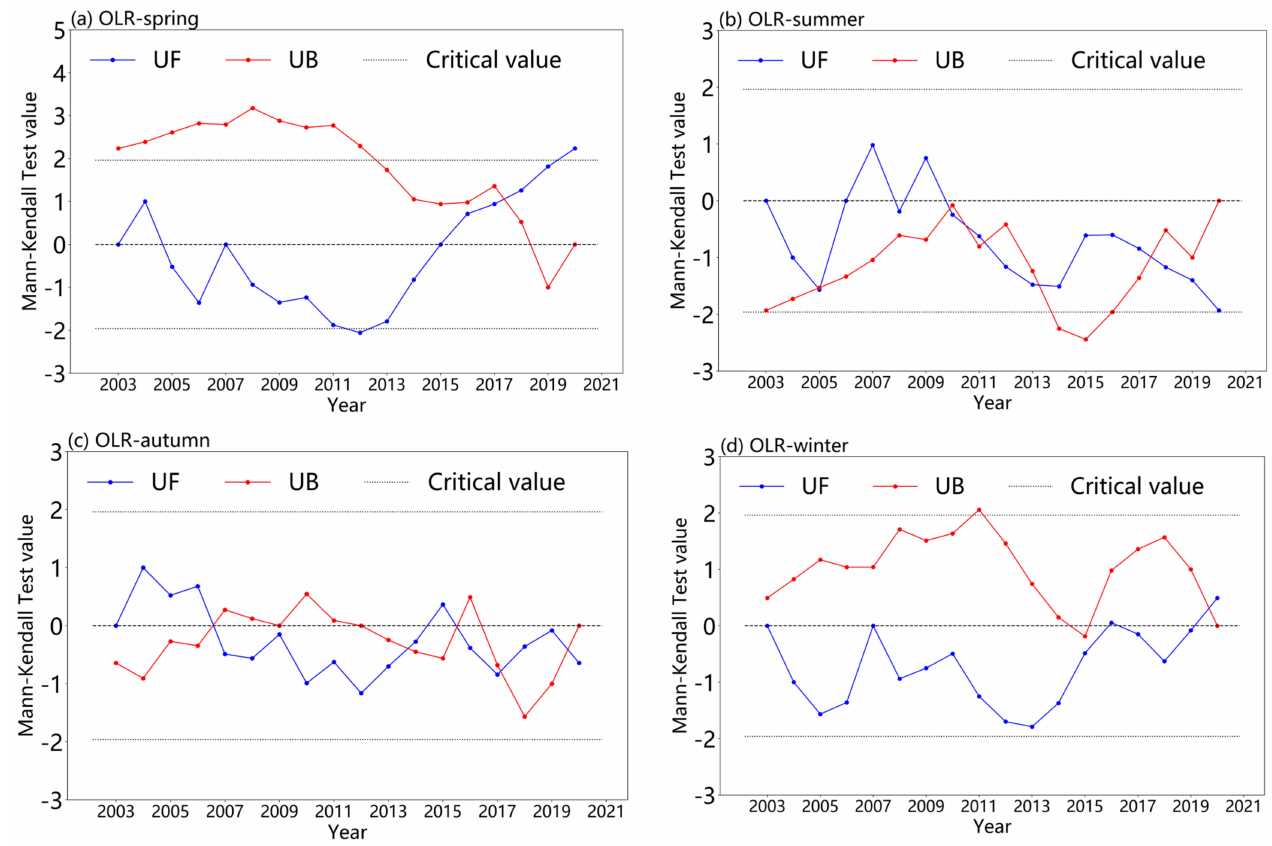
Figure 5. Four Seasons MK test analysis. ( a ) OLR-spring. ( b ) OLR-summer. ( c ) OLR-autumn. ( d )